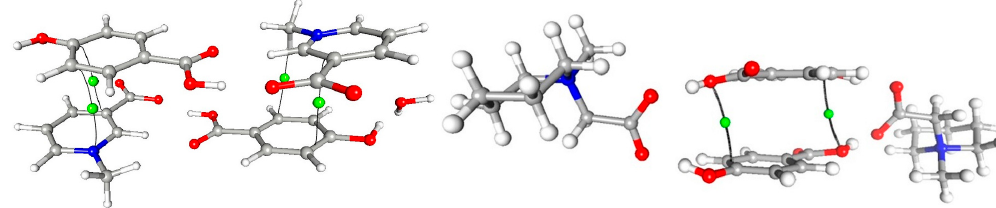
Figure 12. Bond path and associated critical point between aromatic rings in 1 ( left ) and 2 ( right ).